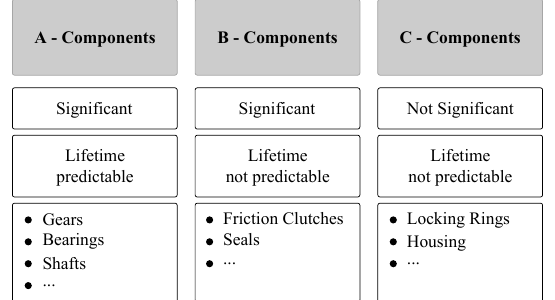
Figure 6: ABC-analysis of components Naunheimer et al.